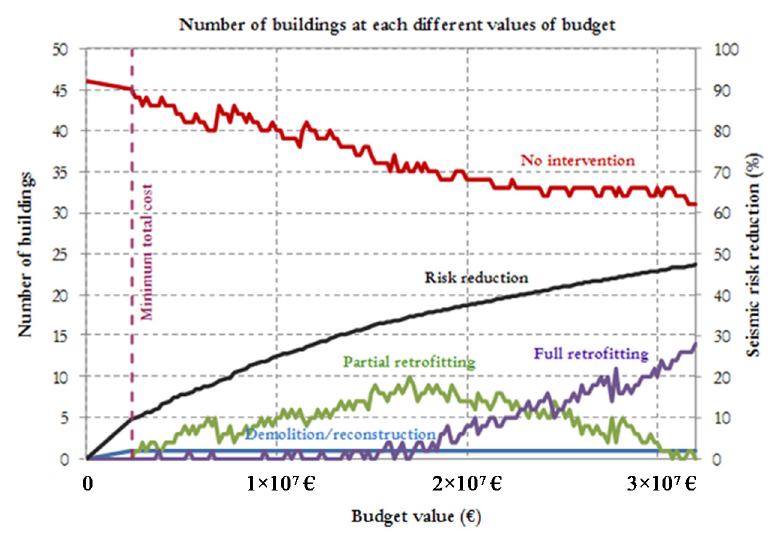
Figure 11. Sensitivity of number of buildings at each decision strategy and total risk reduction to the budget variation.